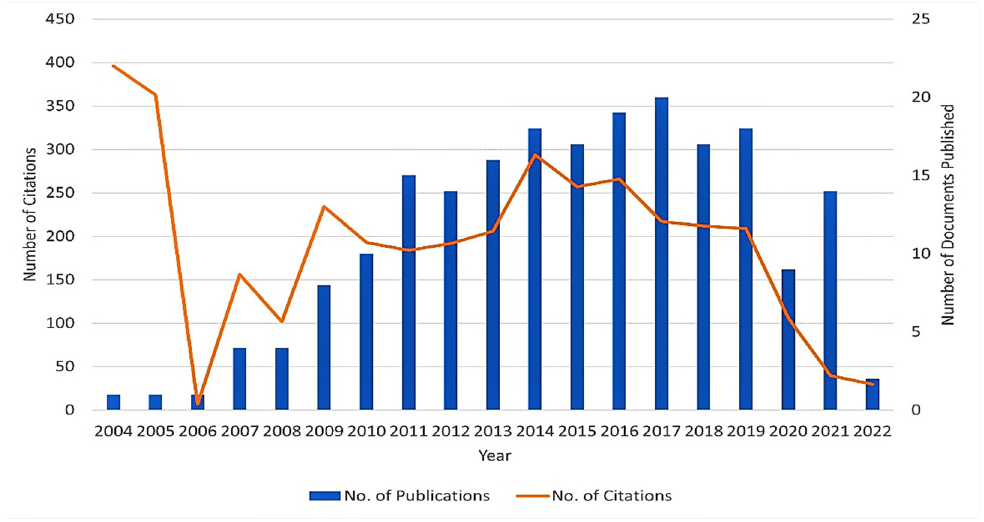
Figure 6. Documents and citations published yearly.